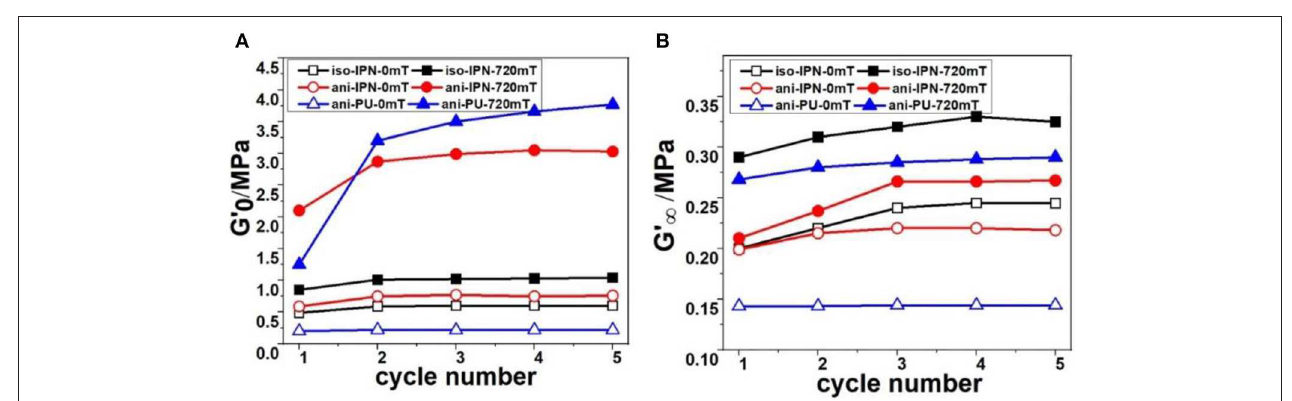
FIGURE 7 | Fitting of the first G ′ γ curve with the increasing strain amplitude obtained in the absence (A) and presence (B) of magnetic field. (Symbols are experimental date, and solid lines are the fitting curves).